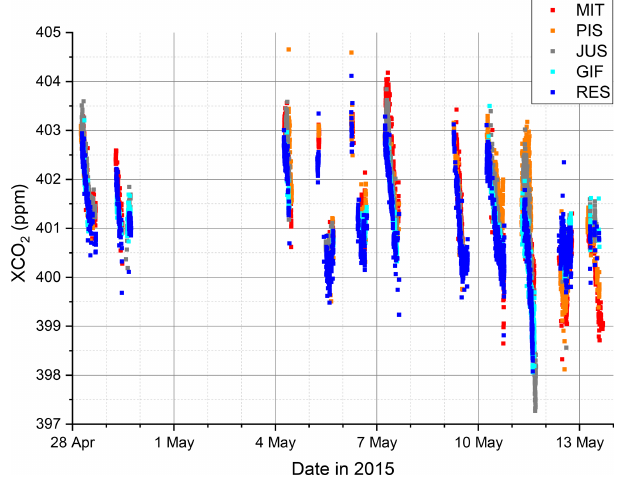
Figure 2. Time series of observed XCO 2 in the Parisian region for all five sites (all valid data of 1min